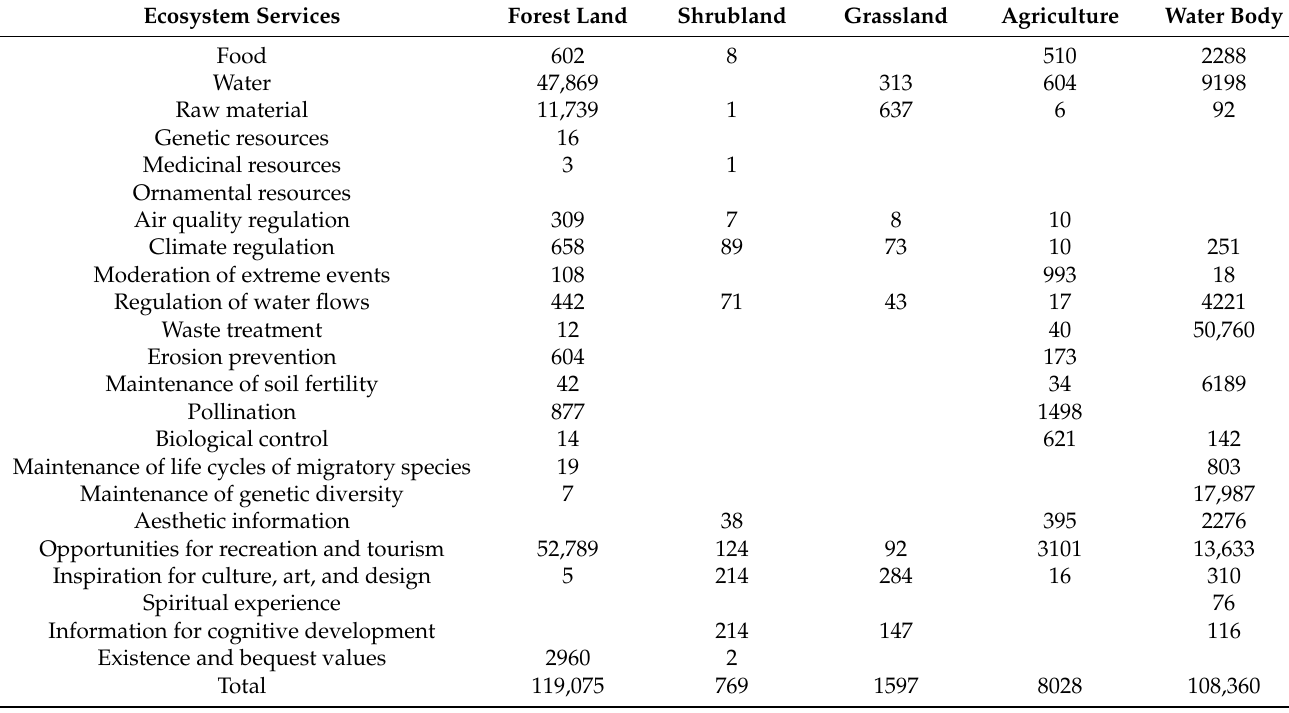
Table 4. Coefficients (Int$/hectare/year; 2020 price levels) of ecosystem service values for the five-land use and land cover